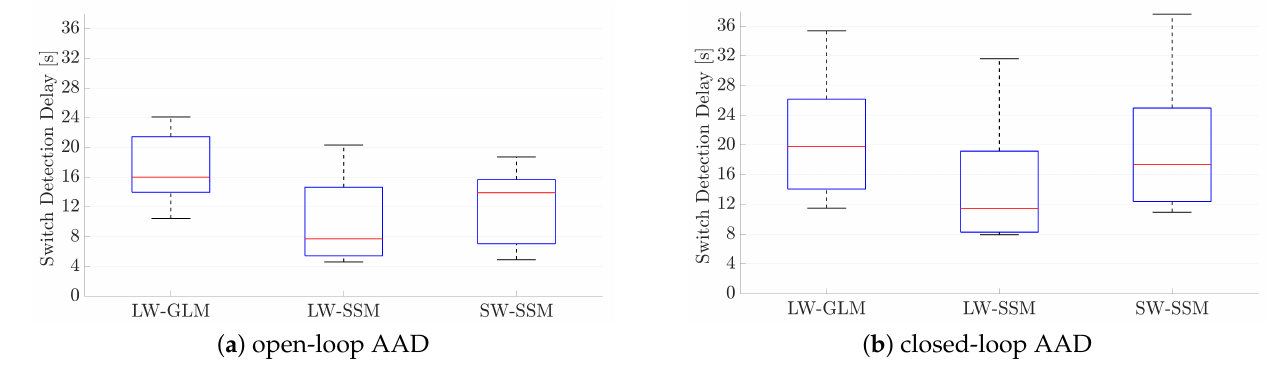
Figure 7. Delay to detect a cued attention switch for ( a ) the open-loop AAD phase and ( b ) the closed-loop AAD phase when using the LW–GLM, LW–SSM, and SW–SSM algorithms. The boxplots display the median, the first quartile, the third quartile, the minimum, and the maximum of the switch detection delay across participants.